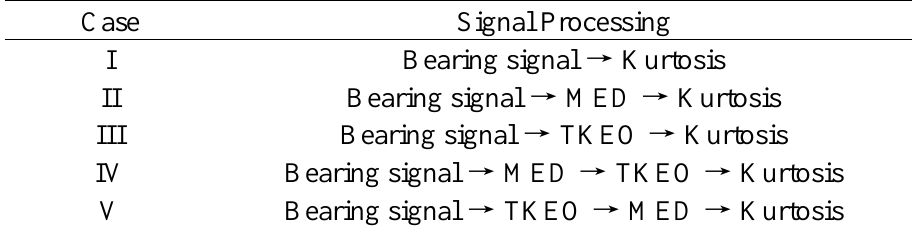
Table 1. Five different Cases (I–V) of signal processing before calculating kurtosis.